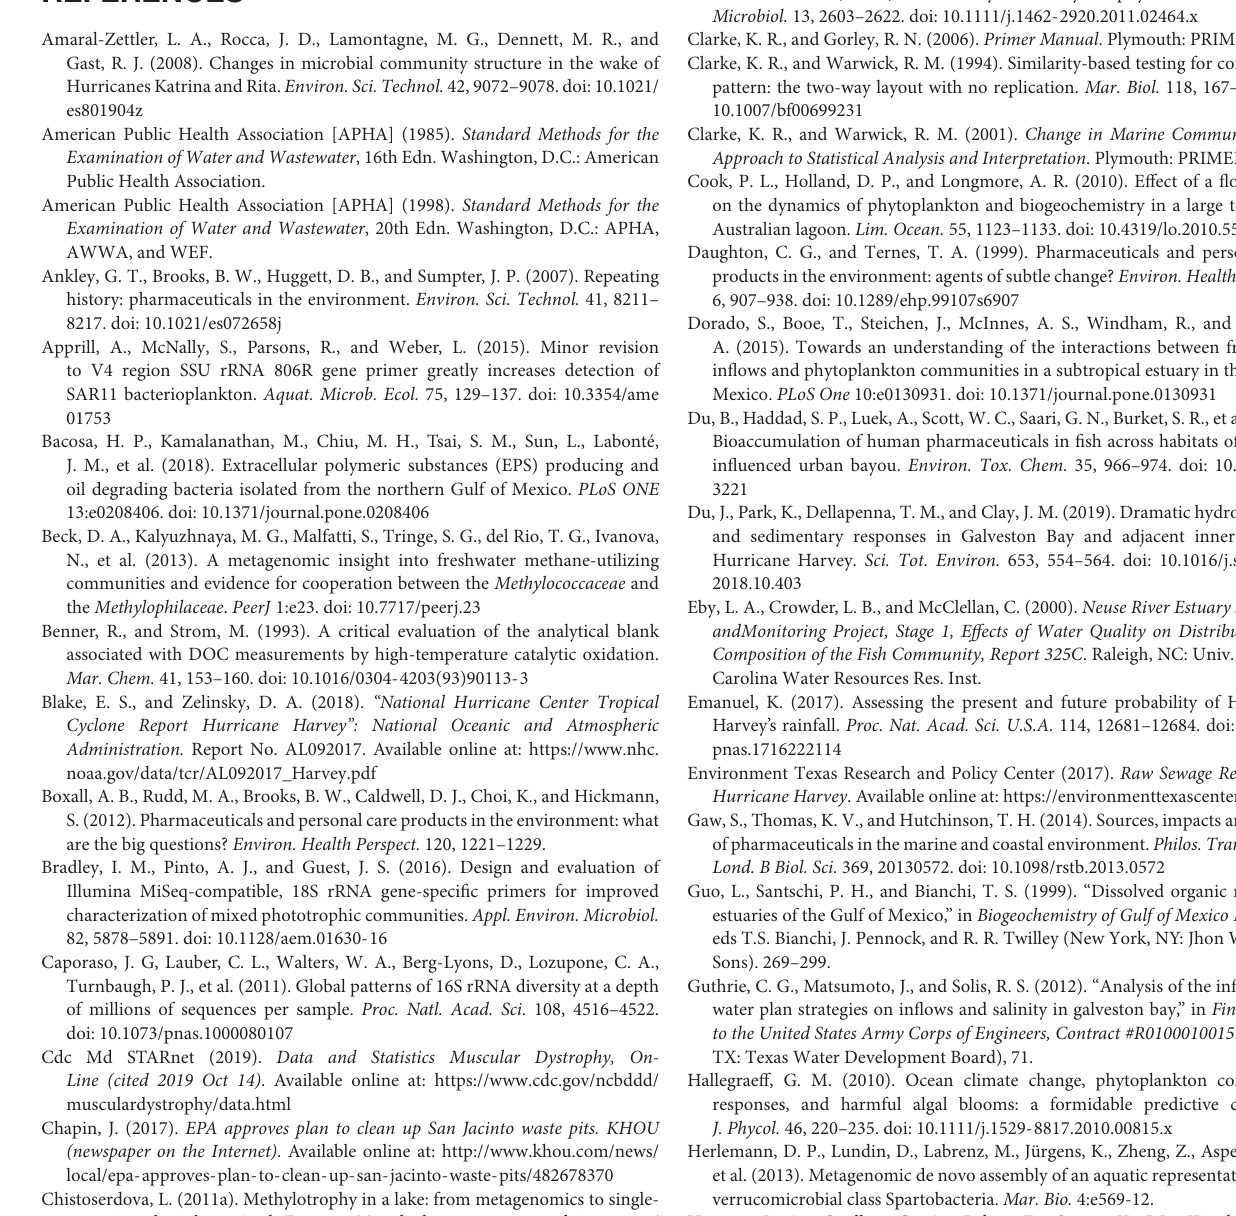
differentiated by color T1 (red), T2 (orange), T3 (green), T4 (blue), and T5 (purple). Environmental data were square root transformed and normalized then used to calculate the Euclidean matrix and construct the PCA. FIGURE S4 | nMDS of biological community showing taxa as vectors (Pearson correlation > 0.8). Stations are shown as differing symbols: 1 (closed upward triangle), 2 (closed downward triangle), 3 (closed square), 4 (closed diamond), 5 (closed circle), 6 (open upward triangle), 7 (open downward triangle), 8 (open square), 9 (open diamond), 10 (open circle). Time points are differentiated by color T1 (red), T2 (orange), T3 (green), T4 (blue), and T5 (purple). nMDS constructed from square root transformed values from the 16S and 18S rRNA OTU abundance data that were used to construct a Bray–Curtis similarity matrix.